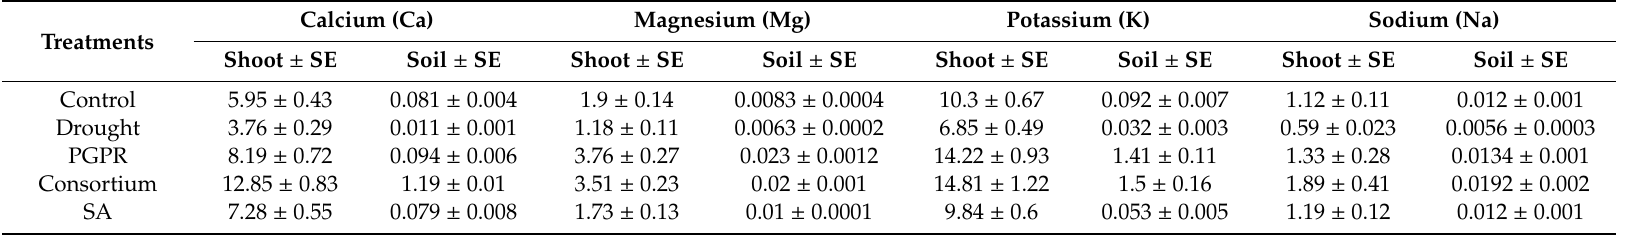
± SE-represents standard error